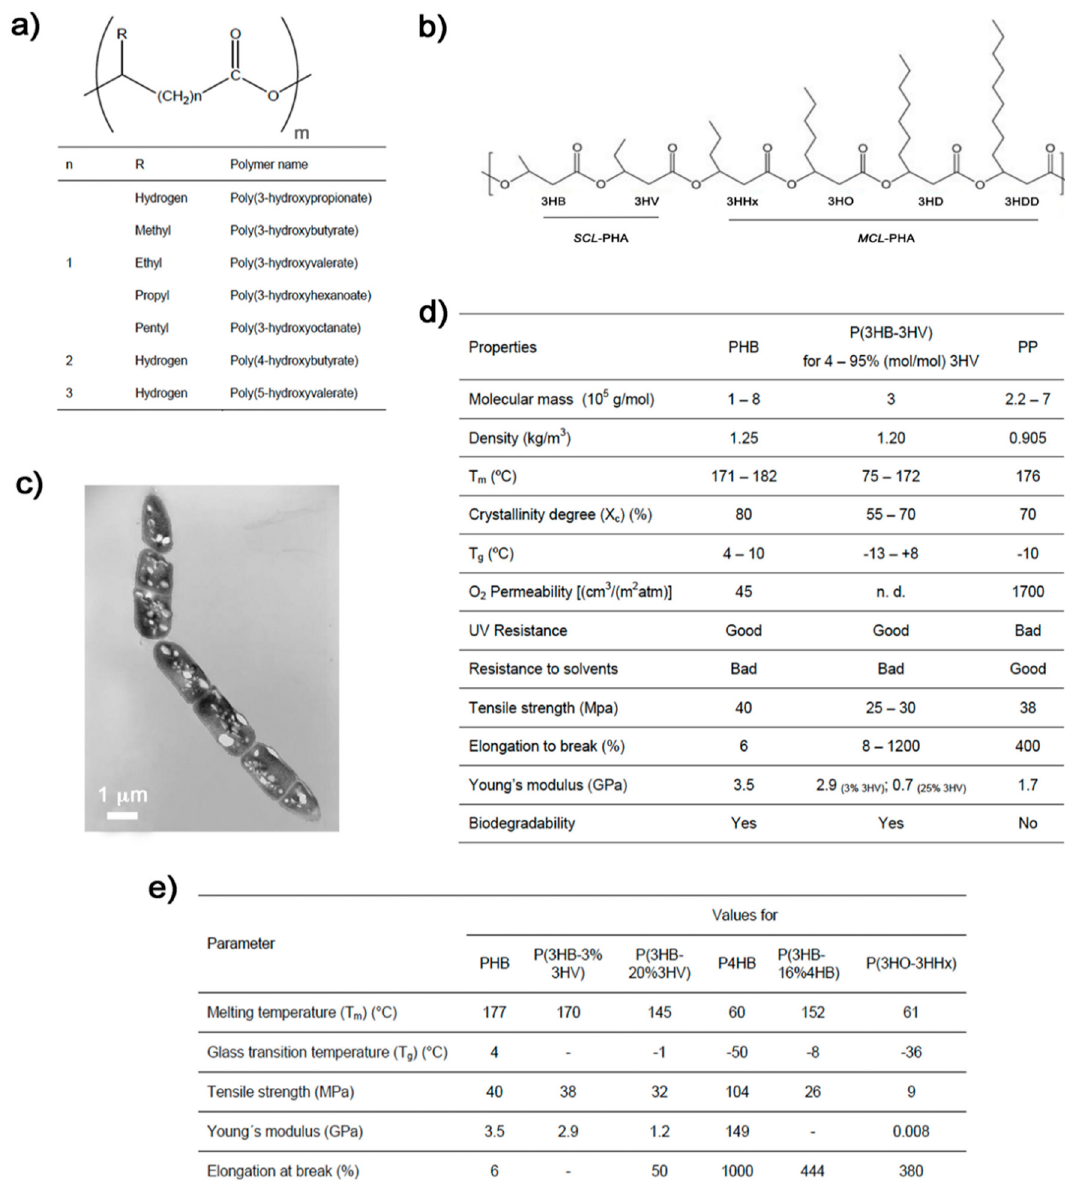
Figure 1. ( a ) Chemical structure of the polyhydroxyalkanoates (PHA) biopolymer family, the